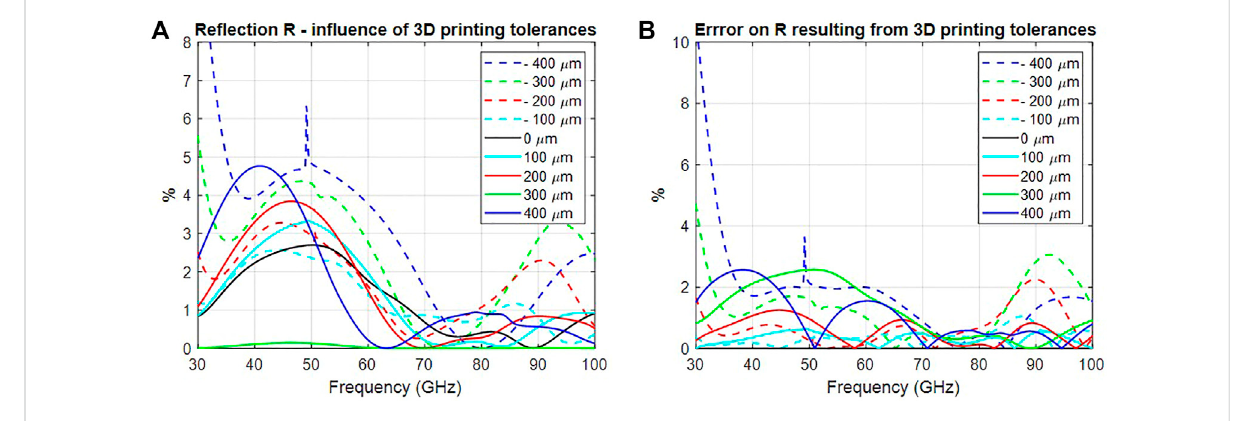
FIGURE 11 (A) In fl uence of 3D manufacturing tolerances on re fl ectivity R (B) Error on